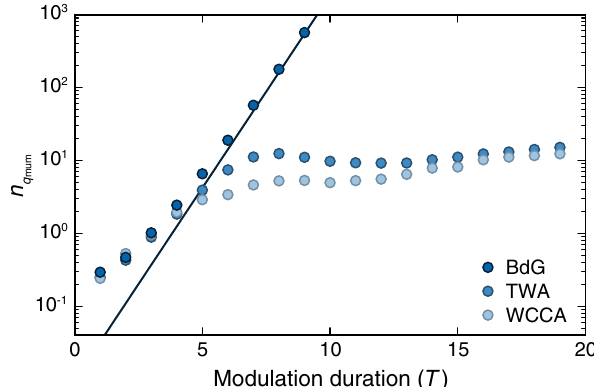
FIG. 9. Numerical simulations of the occupation of the most unstable mode n for a homogeneous 2D system (1D lattice q mum and one continuous direction) for g ¼ 9 . 52 J , ℏ ω ¼ 9 . 25 J , and α ¼ 1 . 44 . The solid line displays the rate obtained from the analytic formulas in Eqs. (A5) and (A6), which is in agreement with the BdG simulations (dark blue) for t ≳ 5 T . The TWA (blue) and WCCA (light blue) partially capture additional nonlinear effects, which result in a time-dependent instability rate.